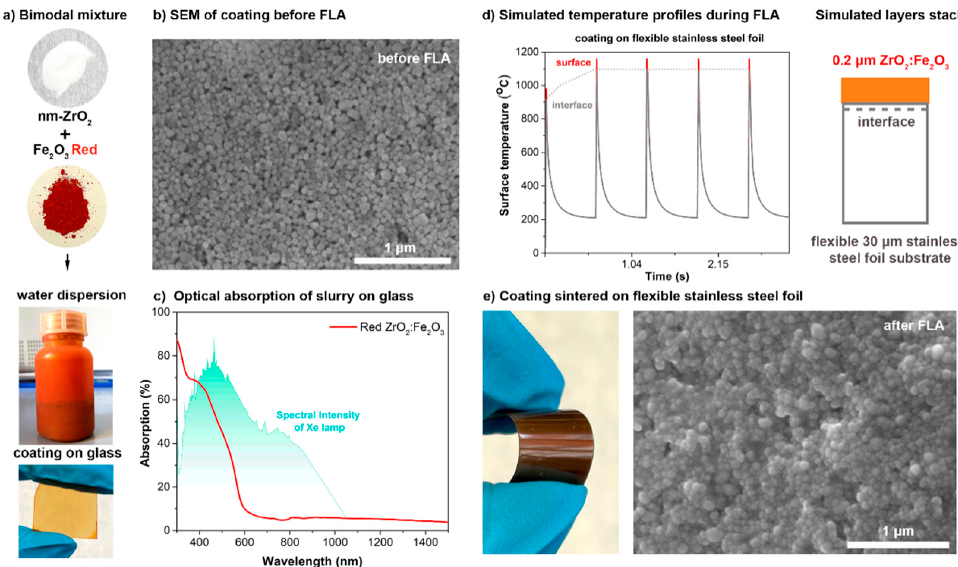
Figure 5. Characterization of the red ZrO 2 : Fe 2 O 3 ceramic film before and after FLA: ( a ) powder components comprised a bimodal mixture of nanometer-sized ZrO 2 and nanometer-sized red α - Fe 2 O 3 , which were mixed with a water-based slurry and deposited onto a glass slide for the ( b ) SEM morphological characterization and ( c ) optical absorption spectra of as-prepared red ceramic films; ( d ) simulated temperature profiles on the surface of the ceramic layer during the FLA process for layer deposited on glass and ( e ) flexible metal foil.